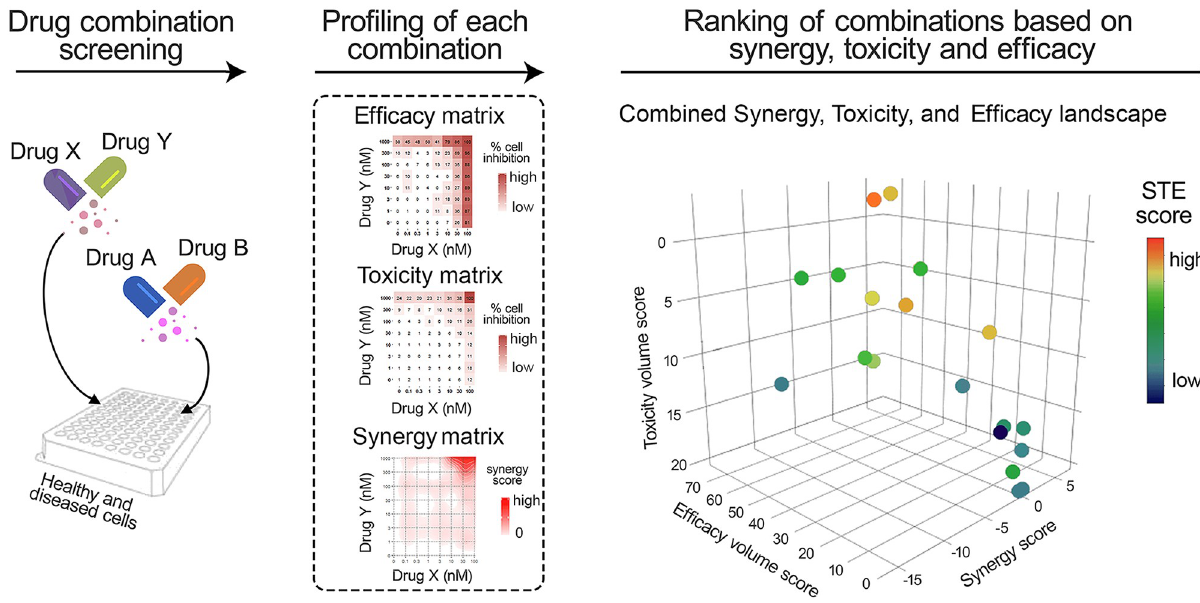
Fig 1. A schematic overview of SynToxProfiler. The dose-response data from drug combination screening, measured in both diseased (e.g. patient- derived cells) and healthy control cells (e.g. PBMCs), is provided as input to SynToxProfiler (left panel). Then, SynToxProfiler quantifies drug combination efficacy and synergy (using combination responses in diseased cells) as well as toxicity (using combination responses in control cells) for each drug pair (middle panel), and summarizes them into integrated synergy, toxicity and efficacy (STE) score. The increase in red color gradient in the efficacy and toxicity matrix (middle panel) denotes an increase in percentage inhibition of cancer and healthy cells, respectively. The color gradient from white to red in the synergy matrix shows the shift of drug interactions from antagonism to synergy. The STE score is further used to rank and visualize the drug pairs in 2D or 3D interactive plots (right panel). The color gradient from blue to red in the right panel depicts an increasing STE score from low to high.